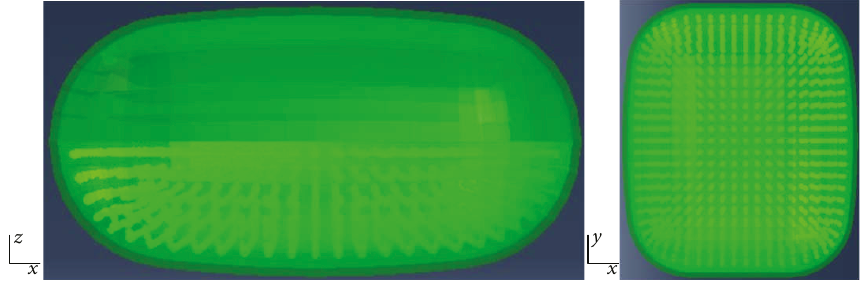
Figure 4: The fi nite element analysis model of the storage tank. Table 2: The material properties for the storage tank.